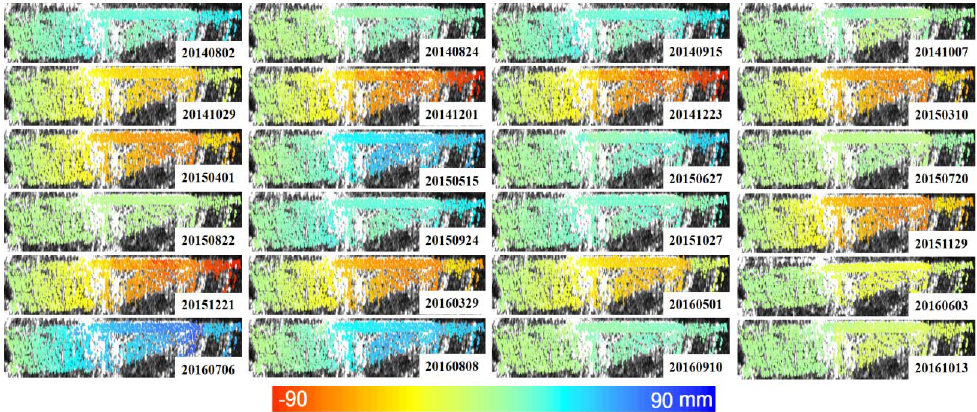
Figure 5. The time series vertical displacements of the SWFC.